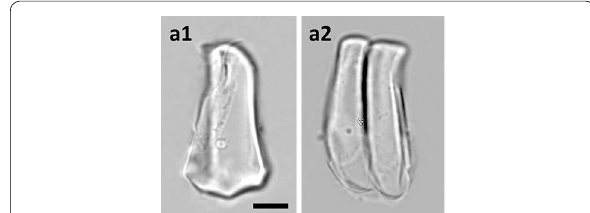
Fig. 11 Bulliform phytoliths of subfamily Micrairoideae. a I. myositis . 1 , end view; 2 , lateral view. a2 , two grains attached. Bar 10 μ m , all pictures are in the same scale